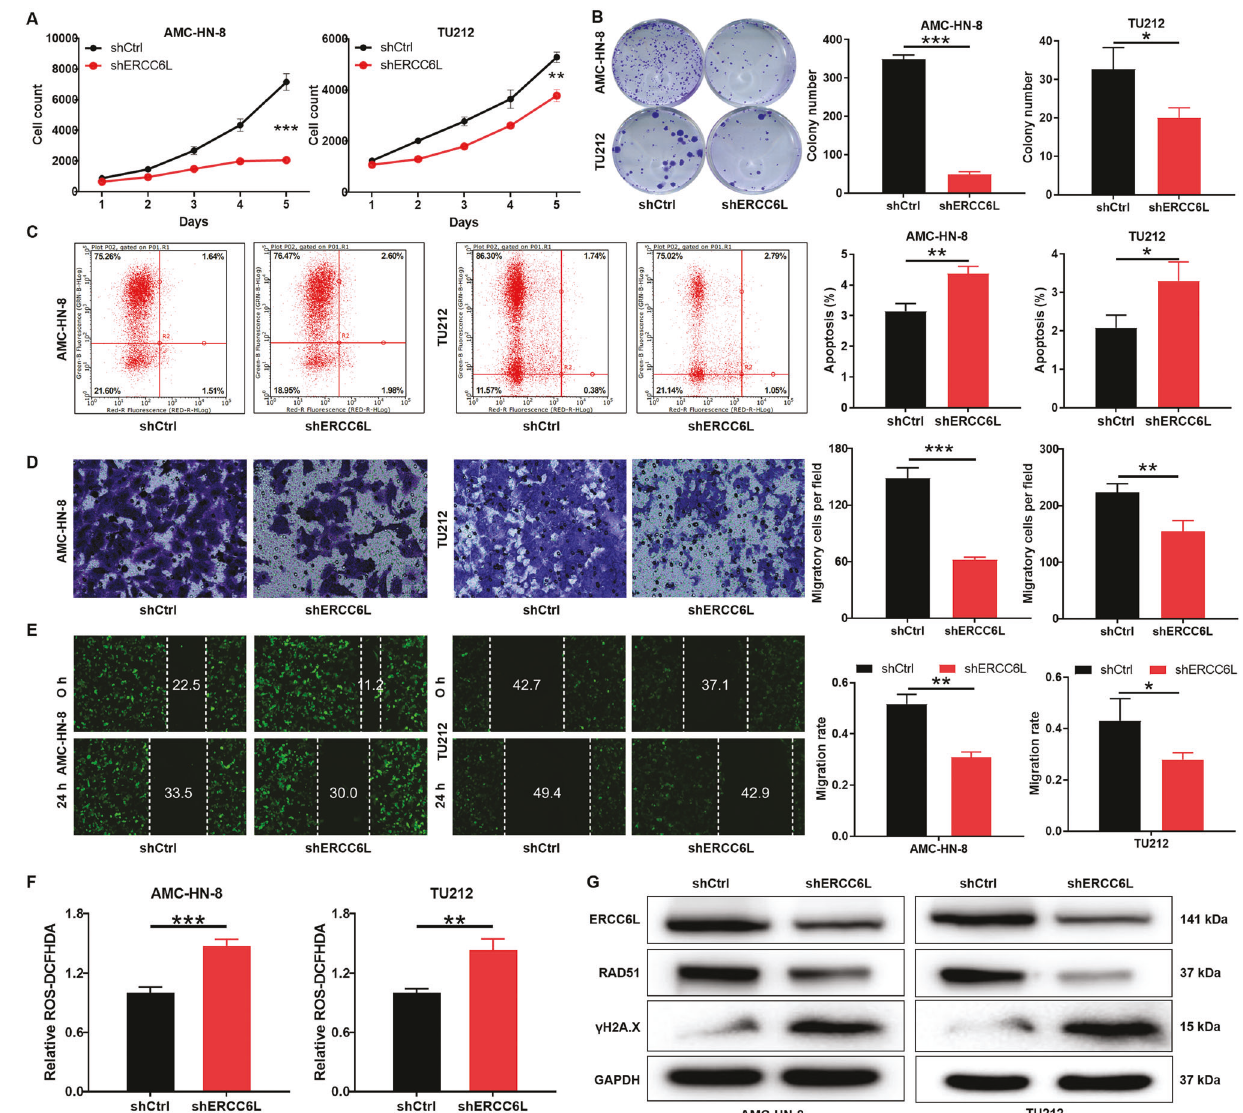
Fig. 2 ERCC6L knockdown inhibits LSCC progression in vitro. A Celigo cell counting assay was employed to show the effects of ERCC6L on cell proliferation of AMC-HN-8 and TU212 cells. B Colony forming ability of the shERCC6L-mediated AMC-HN-8 and TU212 cells was detected. C Flow cytometry was performed to detect cell apoptosis of AMC-HN-8 and TU212 cells with or without ERCC6L knockdown. The shERCC6L- mediated LSCC cell migration ability was accessed by ( D ) Transwell assay and ( E ) wound-healing assay. F The ROS content in the shCtrl group and shERCC6L group was analyzed by Reactive Oxygen Species (ROS) assay. G The protein levels of RAD51 and γ H2A.X in AMC-HN-8 and TU212 cells was analyzed by western blotting. The representative images were selected from at least 3 independent experiments. Data was shown as mean ± SD. * P < 0.05, ** P < 0.01, *** P <